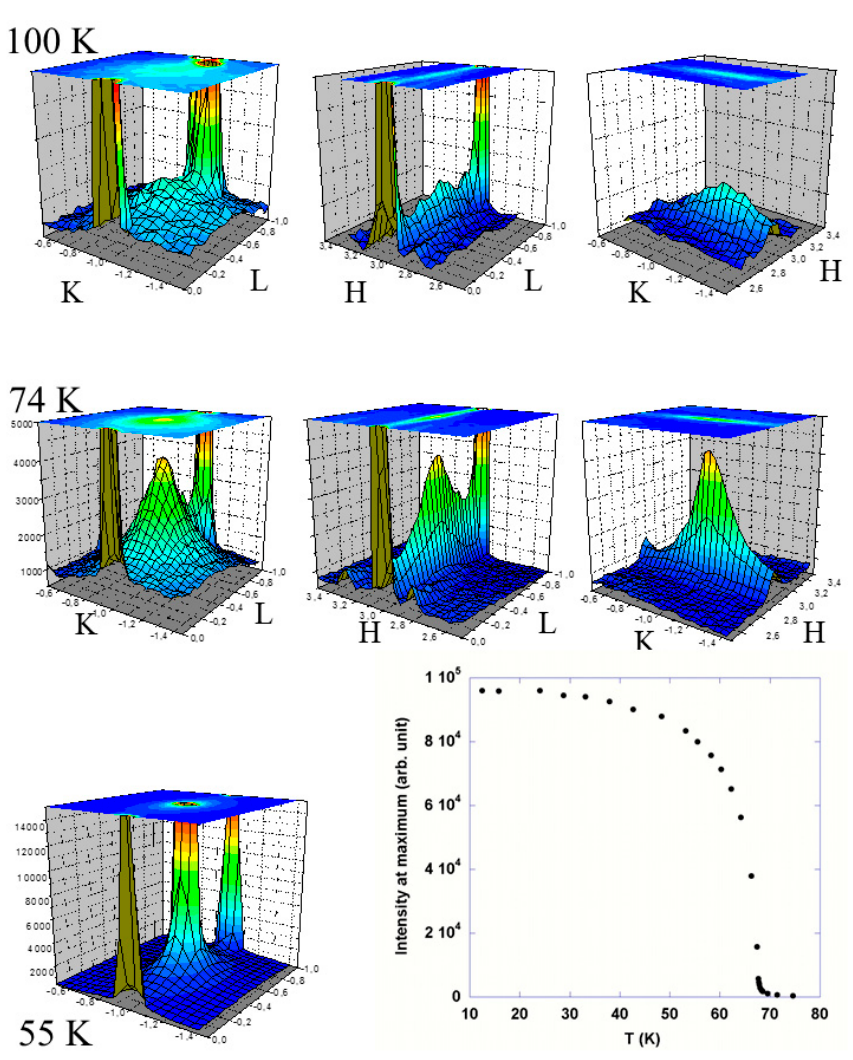
Figure 9. Condensation of the diffuse scattering into a Bragg peak in dimethyltetrathiafulvalene- p - chloranil